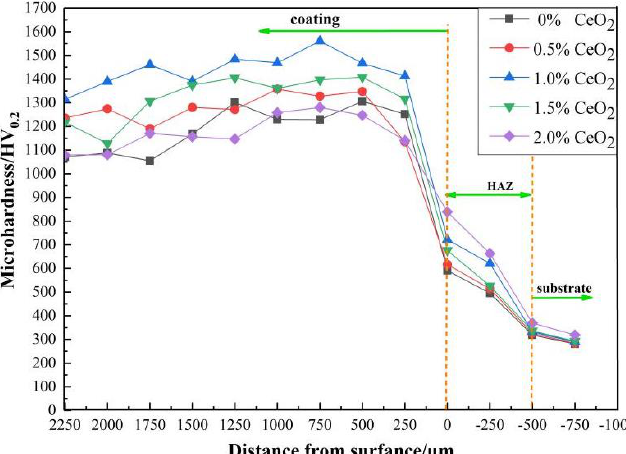
Figure 8. The microhardness distribution curve for the CeO 2 -modified composite coatings with different mass fractions.